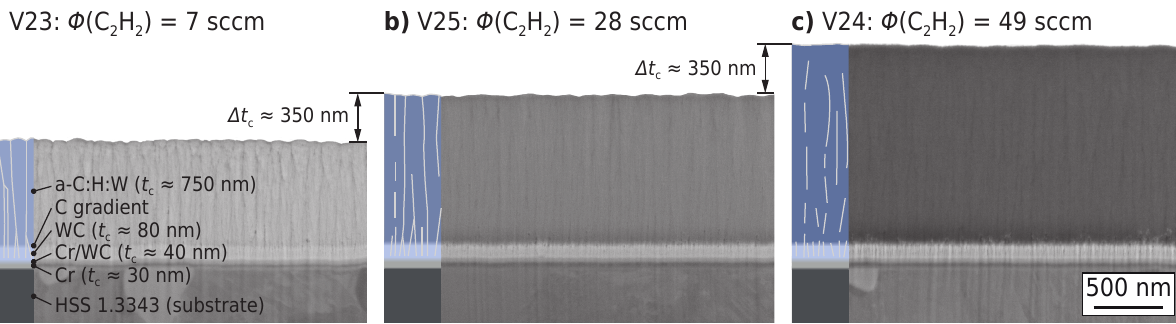
Figure 2. Focused ion beam (FIB) cross-sections of three a-C:H:W coating variants that were deposited at different ethine flow rates and otherwise identical set points of the deposition parameters (with the schematic overlay to the